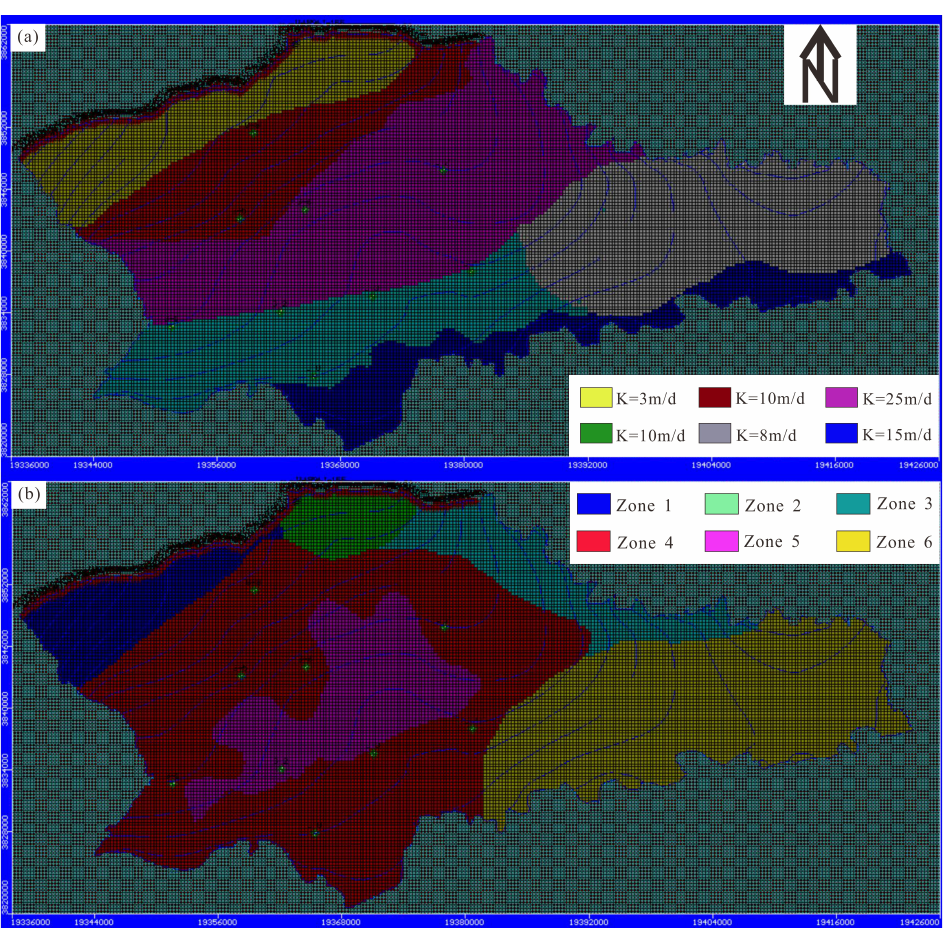
Figure 3. Maps that show the model parameter partition: ( a ) hydraulic conductivity; ( b ) recharge area map. See Table S2 for the specific assignment of